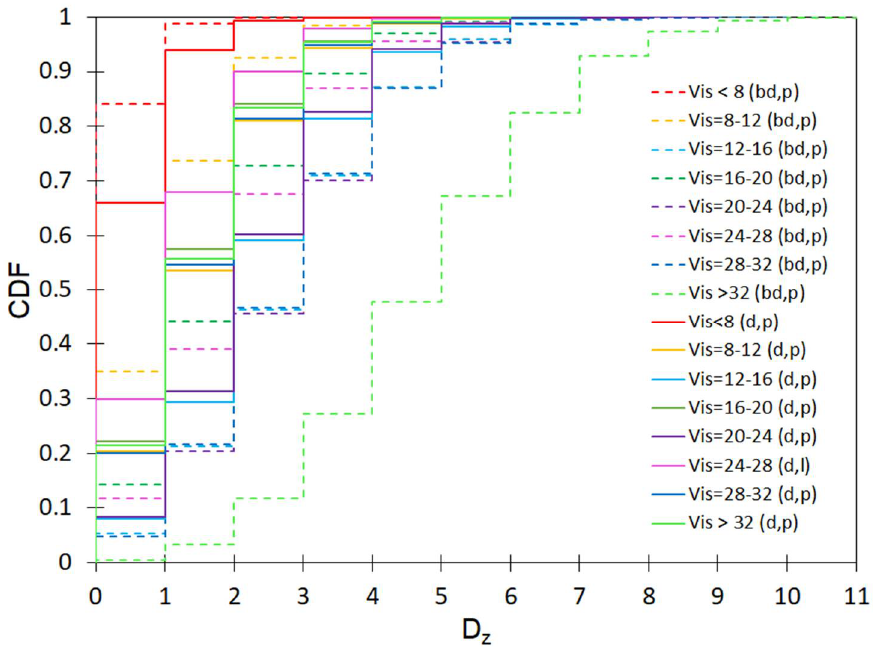
Figure A1. Number of days (D z ) with visibility in the respective range of variability for the precipi- tation and rainless period for summer.